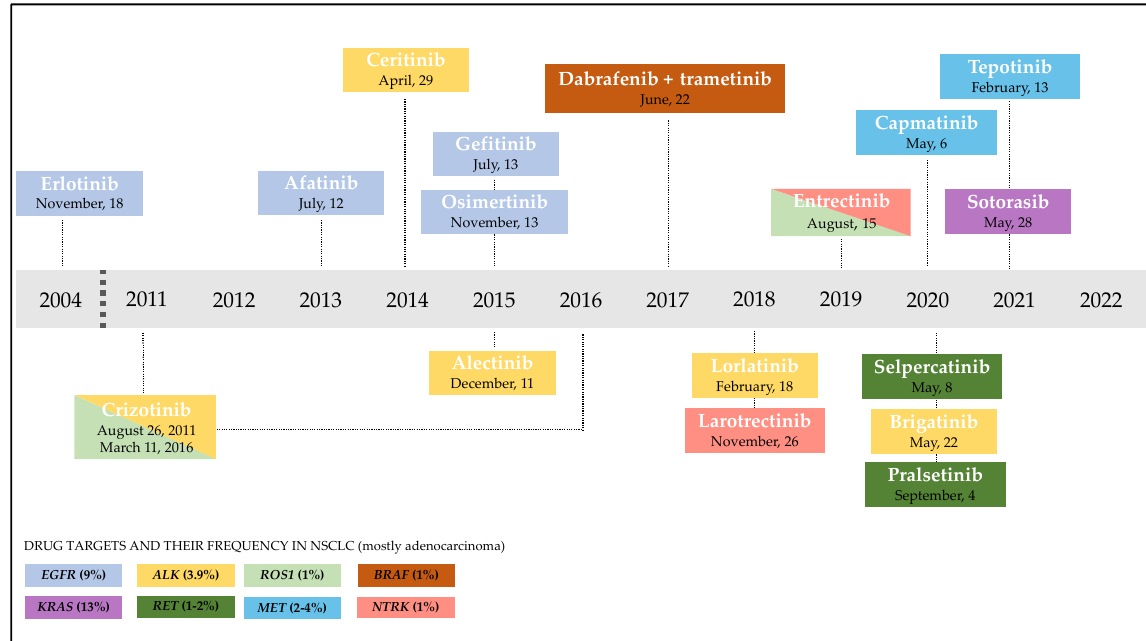
Figure 1. Timeline of FDA approval of targeted therapies for NSCLC (the colors are matched between driver alteration and targeted agent). The identification of actionable biomarkers led to significant progress in the treatment of NSCLC. EGFR alterations are detected in approximately 9% of NSCLC patients [6,7] and in the last two decades several agents targeting sensitive mutations received approval from the FDA. The first–generation EGFR–TKI inhibitors, erlotinib and gefitinib, received FDA approval for the treatment of advanced NSCLC in November 2004 and July 2015, respectively. Afatinib is the most studied second–generation inhibitor and received approval in July 2013. Two years later, the third–generation TKI-inhibitor, osimertinib, was initially approved for the treatment of EGFR–T790M mutation positive NSCLC, then in April 2018 it received approval as a first–line treatment for EGFR mutated NSCLC. ALK fusion–positive tumors account for 3.9% of NSCLC adenocarcinomas [8]. Several targeted drugs are available for this subset of patients: the first–generation drug crizotinib was approved in August 2011 and then the FDA expanded its use to treat ROS1–positive patients, a rare subgroup accounting for approximately 1% [9]. Second–generation ALK inhibitors, ceritinib, alectinib and brigatinib, were approved by the FDA between April